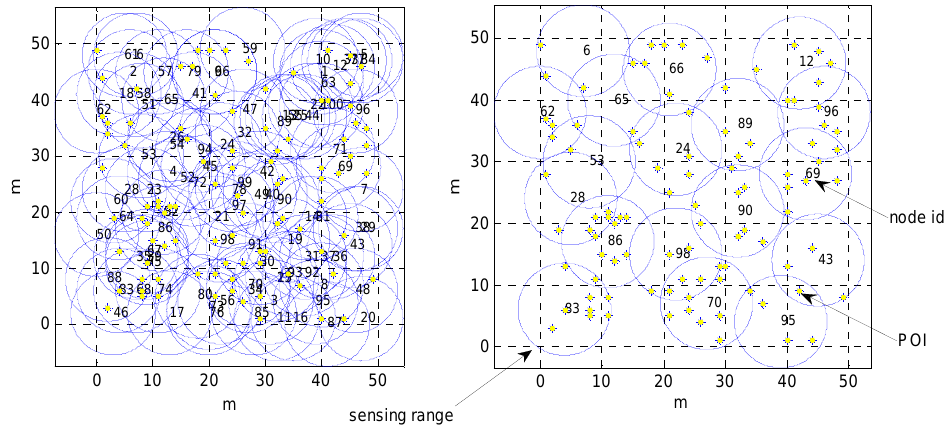
Figure 9. Illustration of random deployments of sensor nodes and POIs in the sample network and the simulation result after applying the CoCMA. (Left) A random deployment of 100 sensor nodes and 100 POIs in a 50 m × 50 m sensing field. (Right) The optimal schedule for nodes is yielded by the